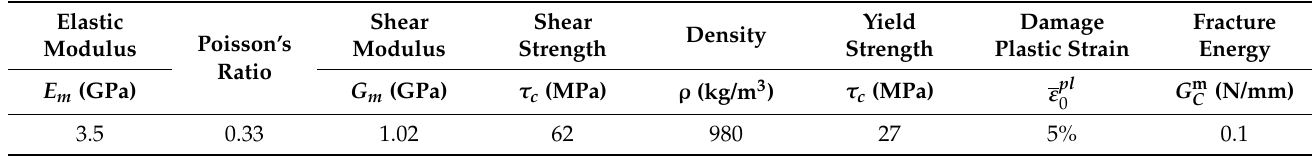
Table 2. Performance mechanical parameters of epoxy resin [19,21].